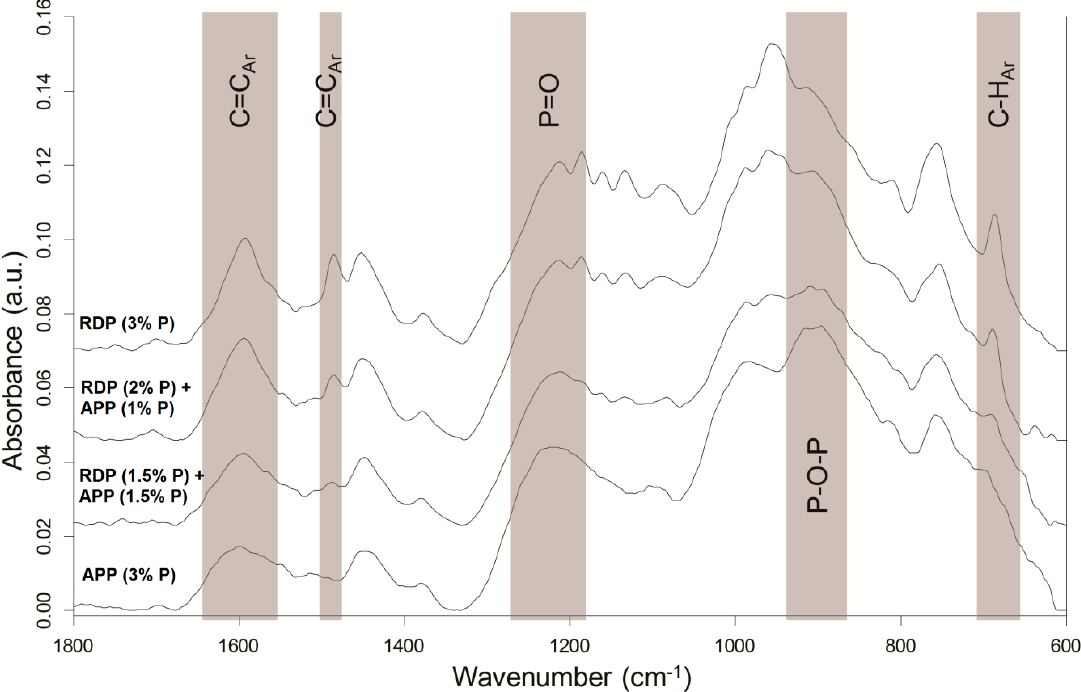
Figure 7. Attenuated total reflection-infrared spectrometry (ATR-IR) spectra of the charred residues from 3% P-containing samples.